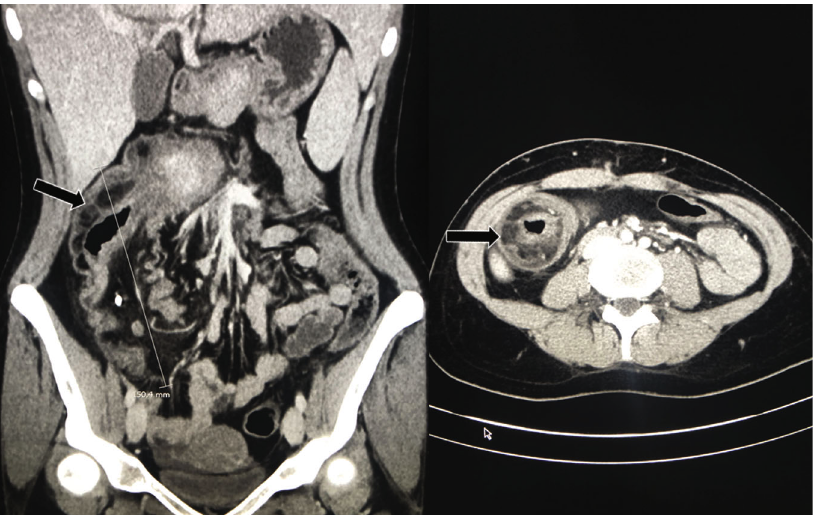
Figure 2: Abdominal computed tomography showing the ileocecal intussusception (left: coronal; right: transverse).